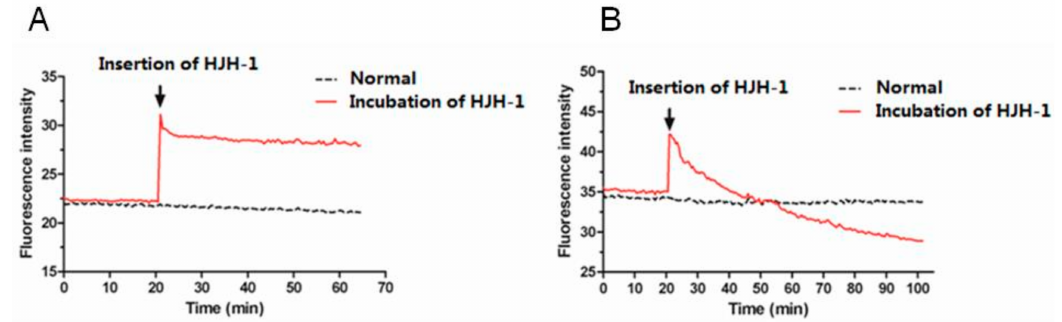
Figure 5. Monitoring of DiBAC4(3). ( A ) Membrane potential of E. coli incubated with HJH-1 (1 × MIC). ( B ) Membrane potential of red blood cell incubated with HJH-1 (1 ×